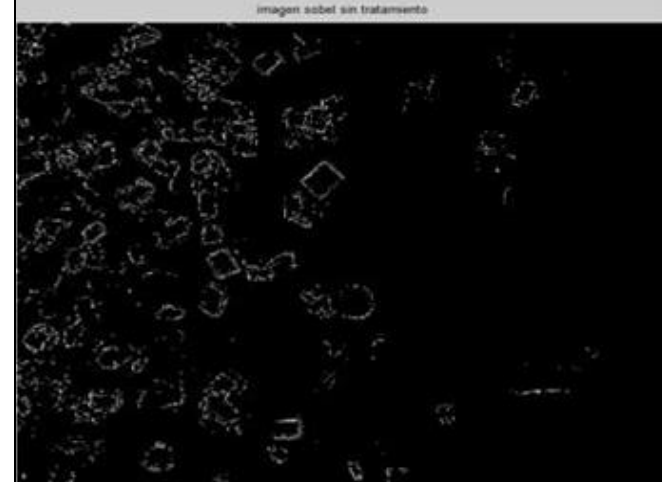
Figura 8: Solución a 80° Brix. Fuente: Los autores, (2018).